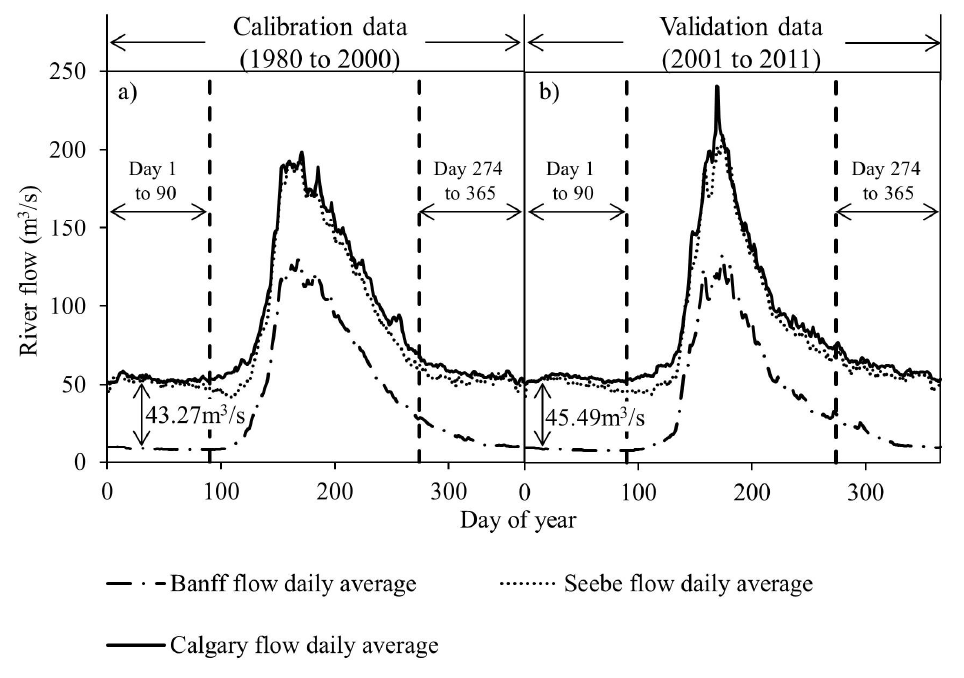
Figure 4. Average daily river flow at each gauge station during the period: ( a ) 1980–2000 ( i.e ., the calibration dataset); and ( b ) 2001–2011 ( i.e ., validation